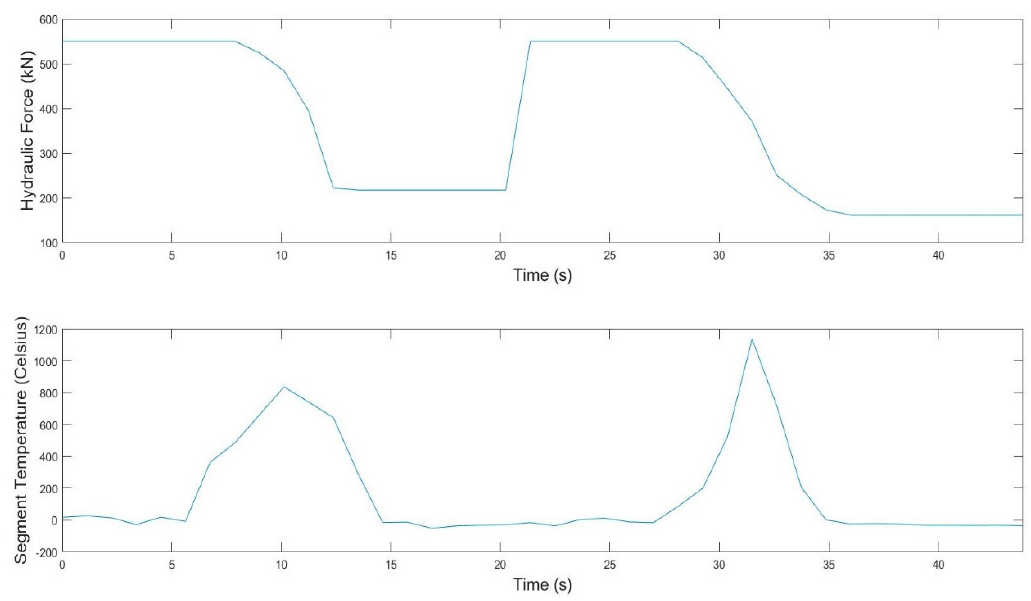
Figure 6. Indicative data plots during the processing of a single trailing arm.